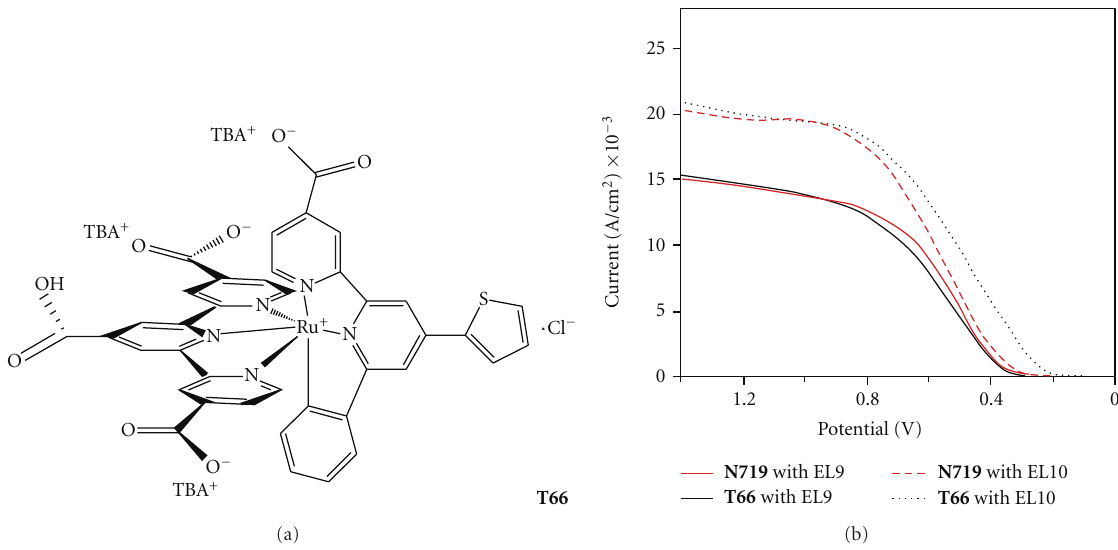
Figure 36: Molecular structure of T66 and current-potential curves of assembled DSSC (taken from [60]).